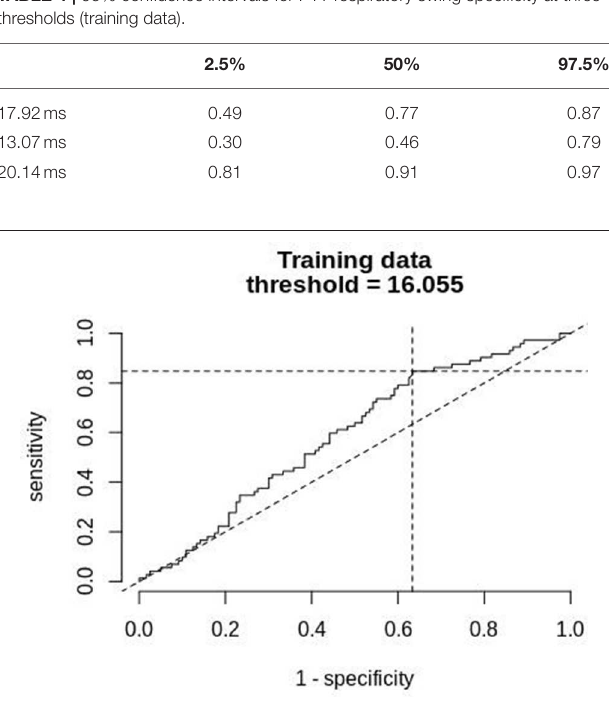
FIGURE 8 | ROC curve of PTT arousal index (training data) compared with a multi-channel study used to detect OSA or UARS.